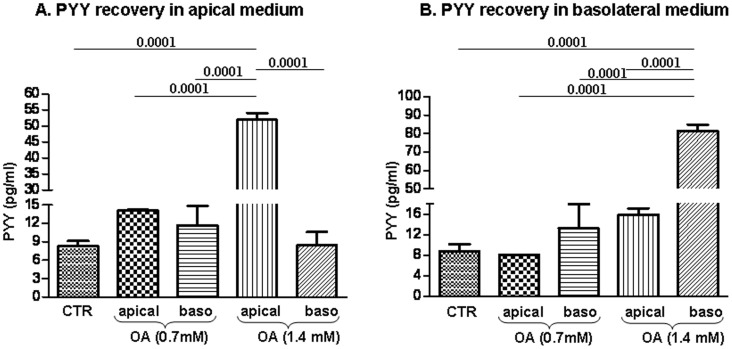
Influence of oleic acid on PYY secretion in the apical and basolateral media.Oleic acid at the concentrations of 0.7 mM and 1.4 mM was added either to the apical or basolateral medium. Following the 2-h incubation period, both apical and basolateral media were assessed for their PYY content. Values are expressed as means ± SD for n = 3 separate experiments in each group. CTR, Control; Baso, basolateral; OA, Oleic Acid.